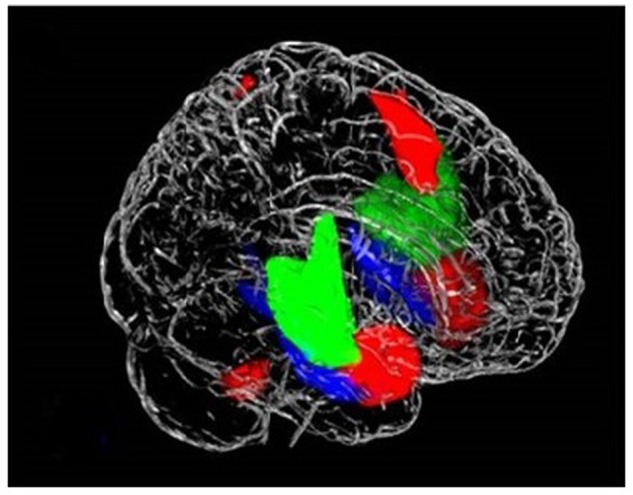
Three networks that contain the insula, (1) posterior insula (green) accounts for sensorimotor, pain, and language processing; (2) dorsal anterior insula/salience network (red) engaged in higher executive control functions; and (3) ventral anterior insula (blue) responsible for social–emotional processing and autonomic function.